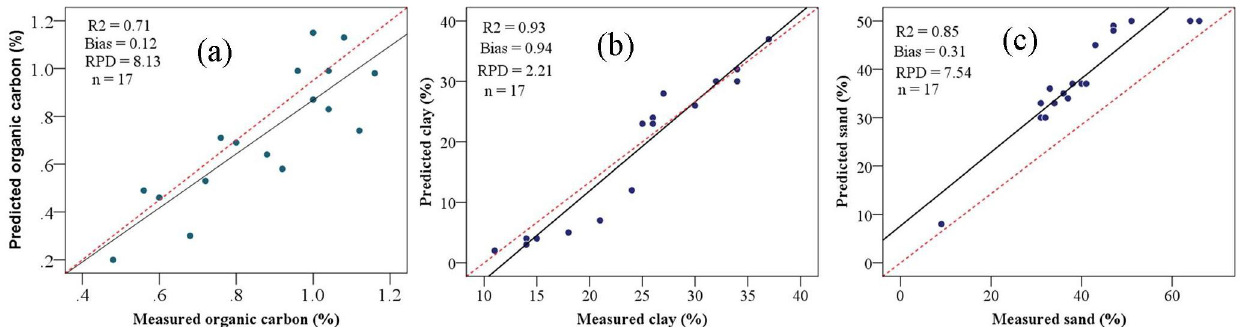
Fig 10. Scatterplots of the model validation results for soil organic carbon (a), clay content (b), and sand content (c). R 2 , coefficient of determination and RPD , ratio of performance to